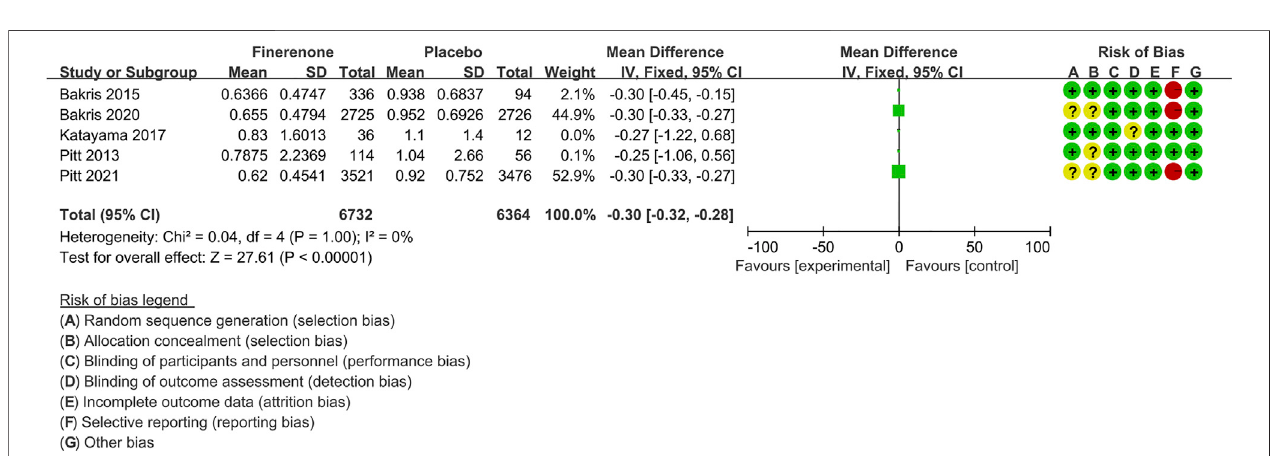
FIGURE 3 | Meta-analysis results of mean of the UACR from the baseline for fi nerenone and placebo patient groups.